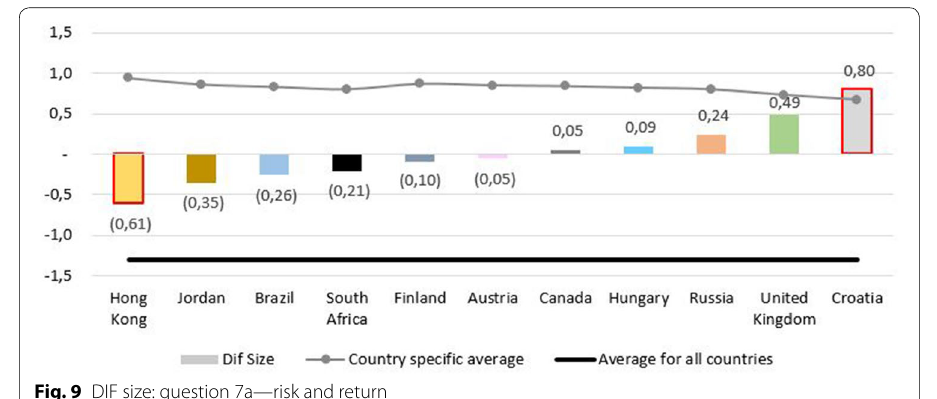
Fig. 9 DIF size: question 7a—risk and return